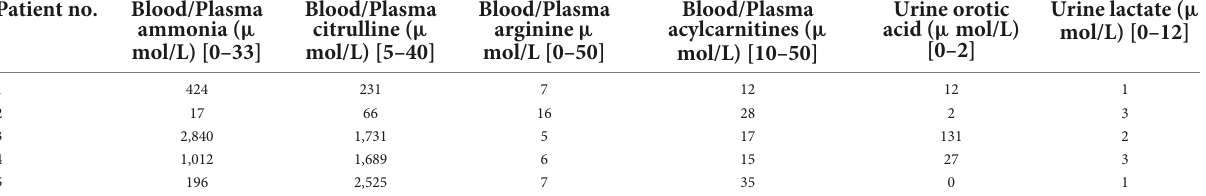
TABLE 3 Tandem mass spectrometry characteristics of the five patients. Patient no.